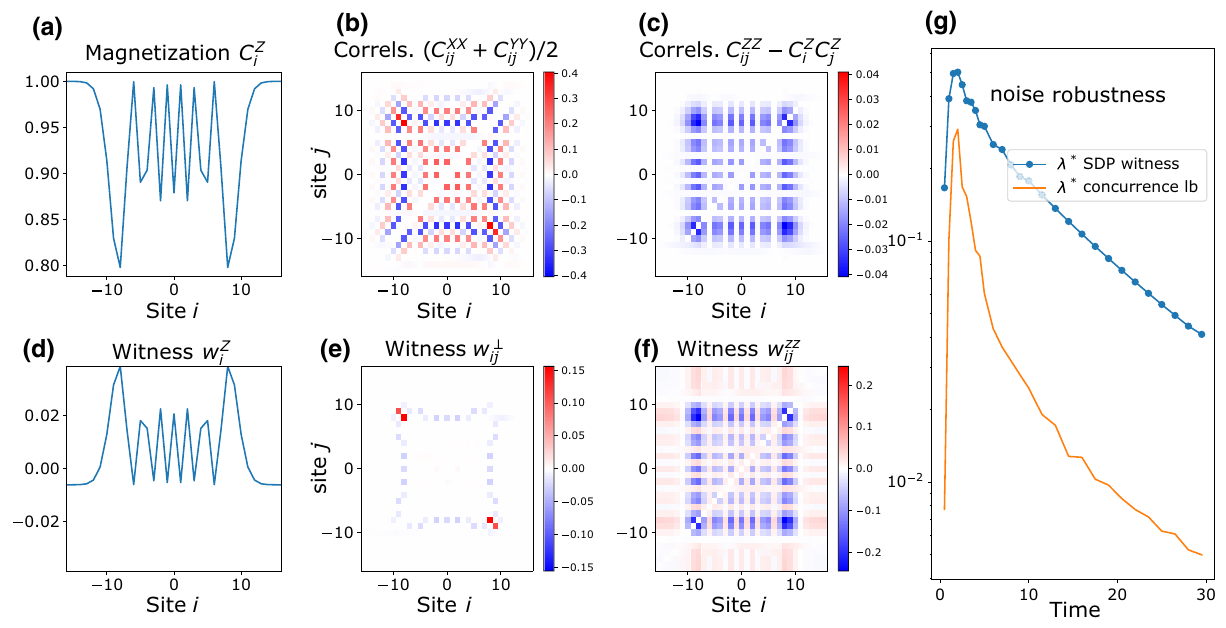
− C Z ]. (d)–(f) C Z ij i j